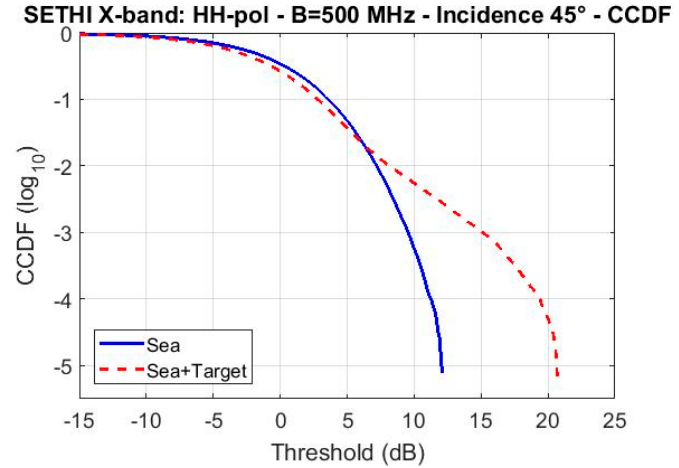
Figure 2. CCDF computed over the two areas shown in Figure 1—blue box: target free area, red box: sea surface including a ship.